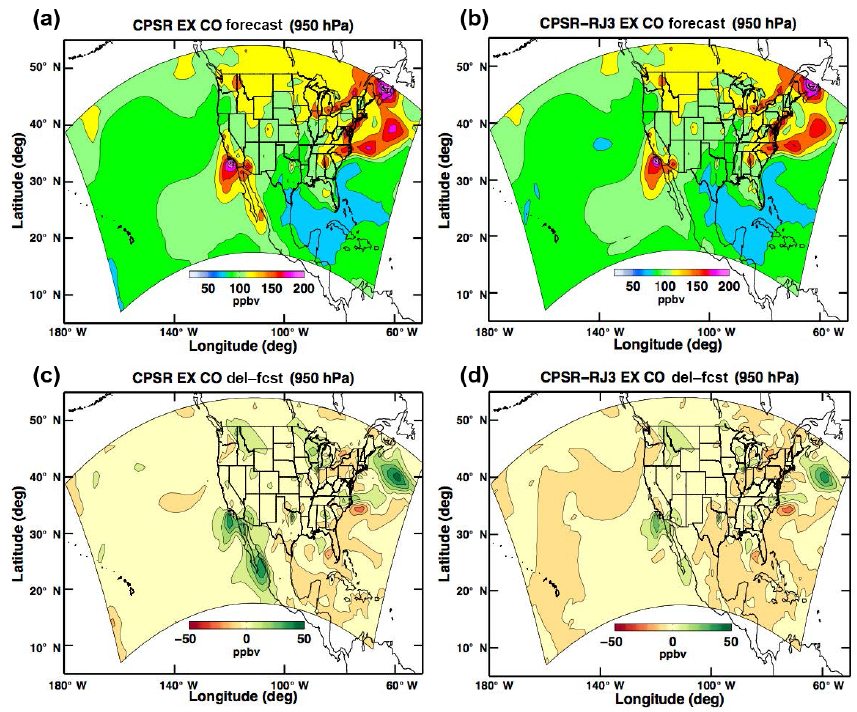
Figure 9. Shaded contours of CO in ppb for the CPSR and CPSR-RJ3 experiment assimilation priors in panels (a) and (b) , respectively, and for the CPSR and MET experiment difference (the CPSR minus the MET experiment, defined as CPSR EX CO Del-Fcst) and the CPSR-RJ3 and MET experiment difference (the CPSR-RJ3 minus the MET experiment, defined as CPSR-RJ3 EX CO Del-Fcst) assimilation priors in panels (c) and (d) , respectively. The CPSR experiments maps in this figure are the same as in Fig. 5 and included for reference. All figures are for ∼ 950hPa on 9 June 2008,